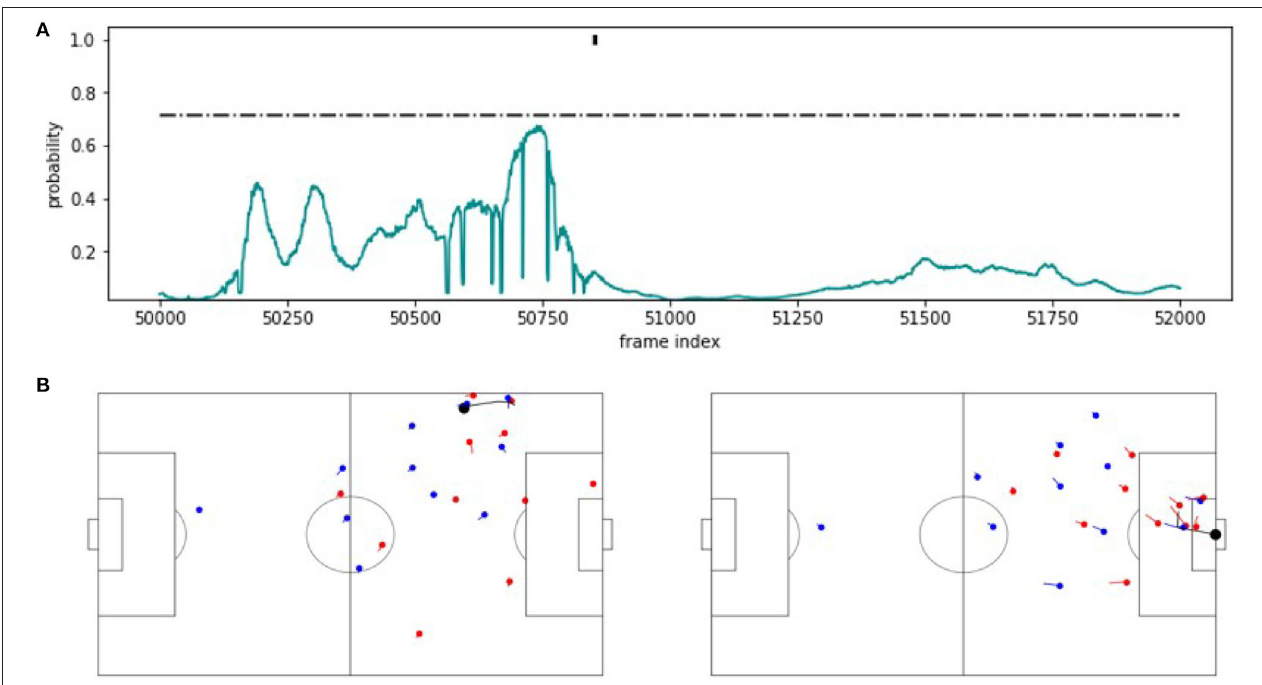
FIGURE 6 | FN example. (A) Predicted probability values for an approximately 80 s excerpt from the validation game. The horizontal line indicates the threshold applied on the probabilities to recognize a counterattack. The mark at the probability value 1 indicates the corner annotation. (B) Snapshot visualizations of a potential start and end point around the counterattack